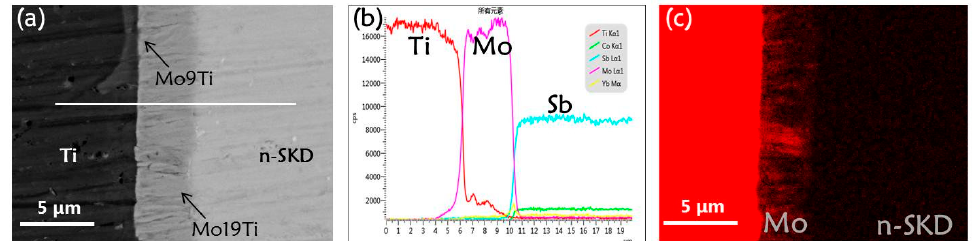
Figure 3. The interfacial microstructure of the Ti/Mo/Yb 0.3 Co 4 Sb 12 joints pretreated at 550 °C for 16 days. ( a ) the BSE graph and spot testing, ( b ) line scan results, ( c ) the distribution of Ti.